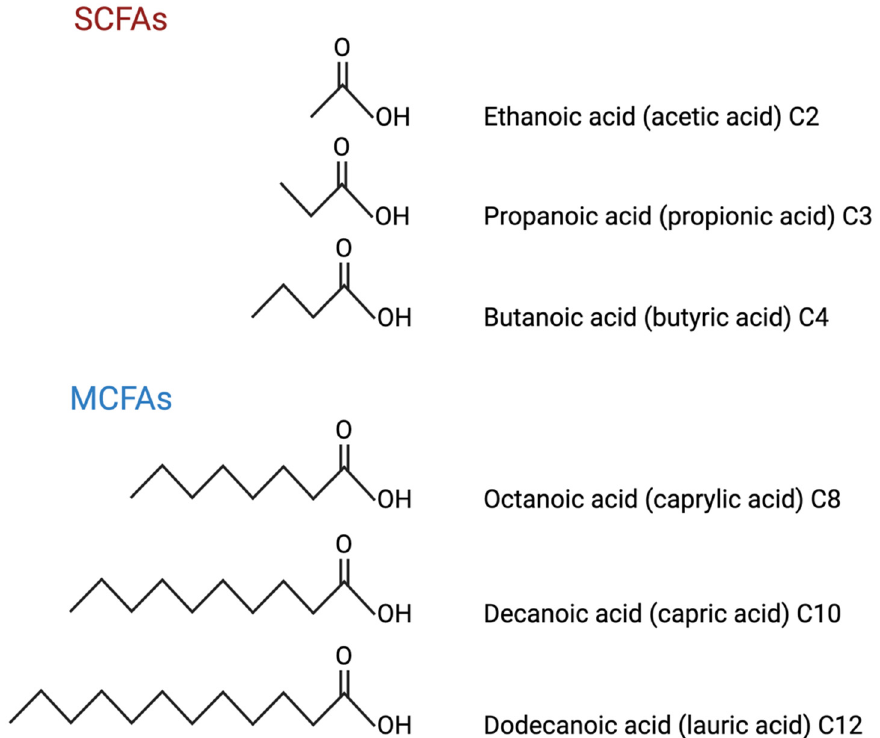
Figure 1. Examples of common SCFAs and MCFAs chemical structures and nomenclature. Figure created with BioRender.